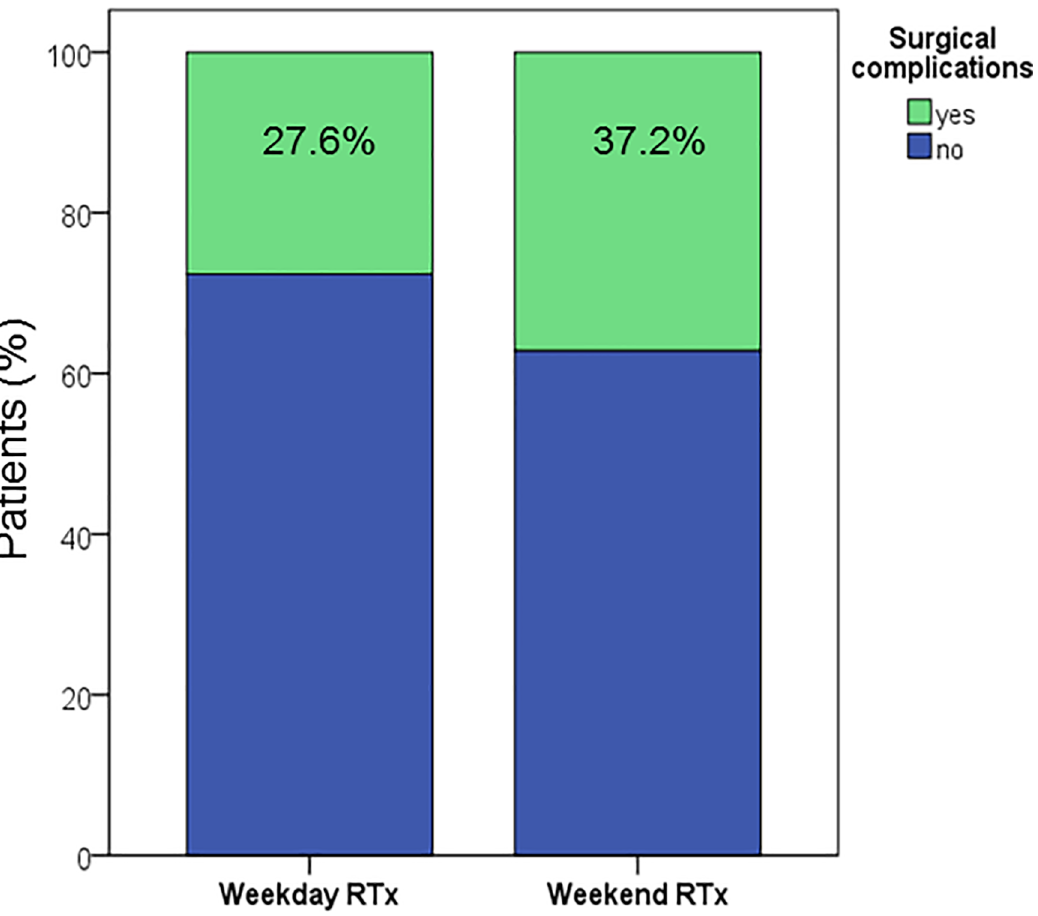
Fig 3. Frequency of surgical complications in weekday and weekend kidney transplant